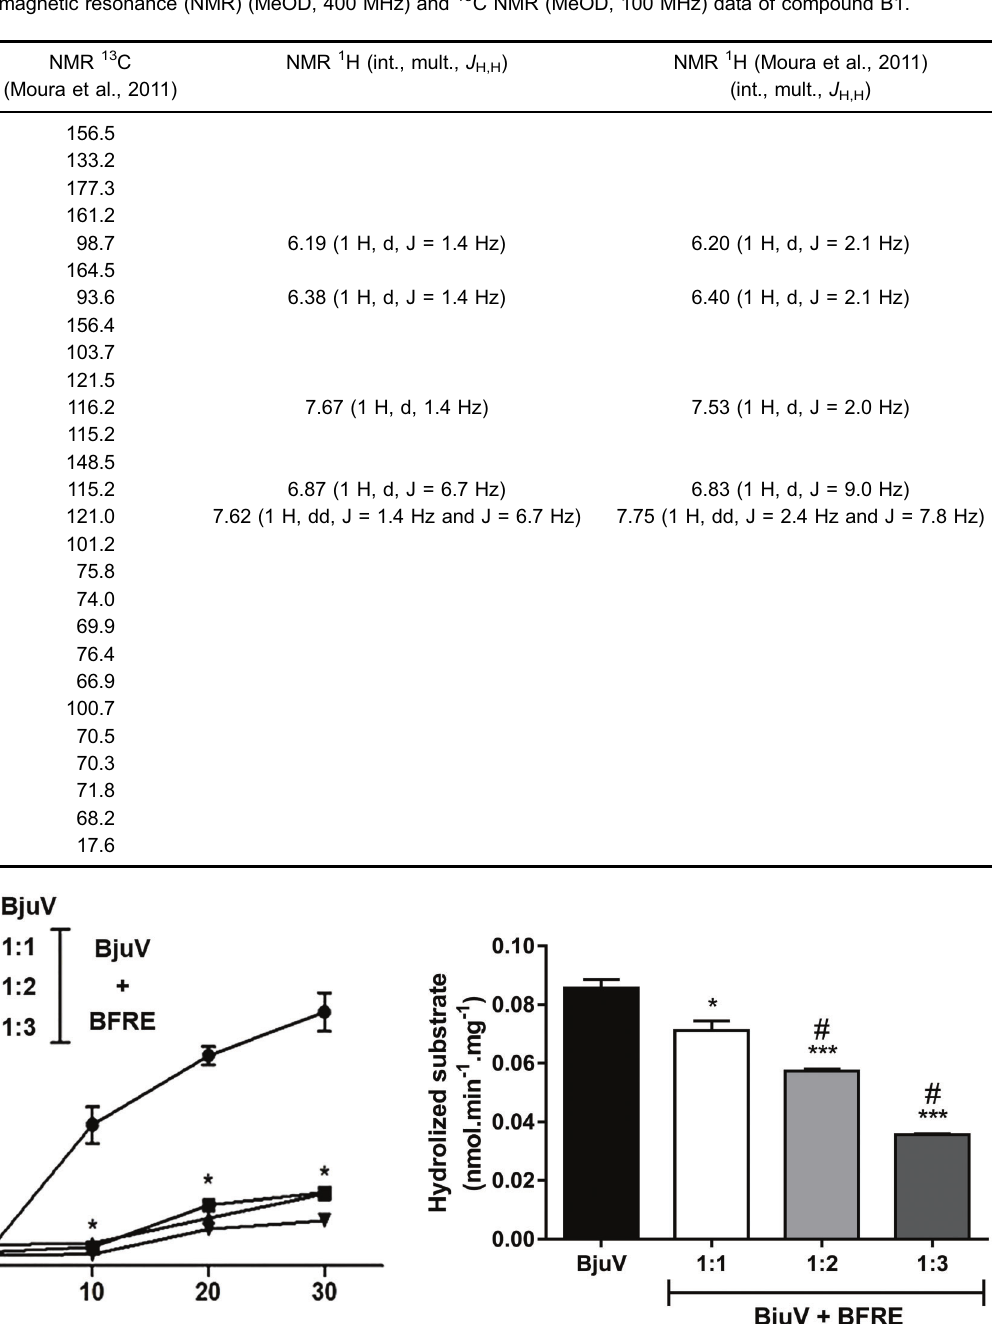
Table 1. 1 H nuclear magnetic resonance (NMR) (MeOD, 400 MHz) and 13 C NMR (MeOD, 100 MHz) data of compound B1.